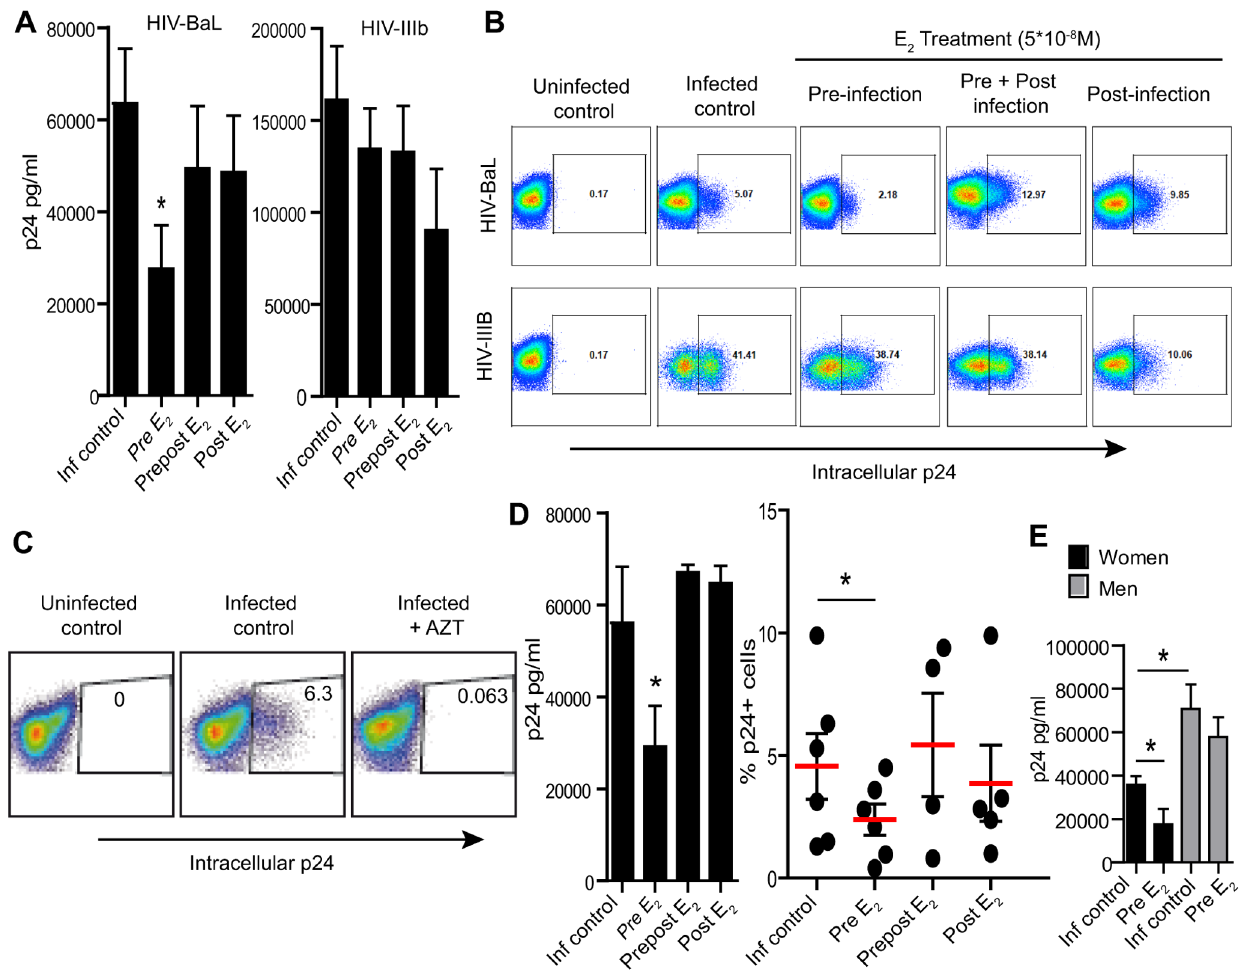
Figure 1. Effect of E 2 on HIV-infection of CD4 + T-cells. A) Released p24 levels in the culture media after 7 days of infection when cells where pre-treated with E 2 for 3 days (pre E 2 ), treated with E 2 before and after infection (prepost E 2 ) or only after infection (post E 2 ). Bars represent mean 6 SEM from 7 independent experiments with different donors. *P , 0.05. B) Intracellular p24 levels after 7 days of infection, representative of n=7. C) Intracellular p24 levels after 7 days of infection in the presence of Zidovudine (AZT). D) Released p24 levels in the culture media (left panel) and intracellular p24 (right panel) after 7 days of infection when cells where pre-treated with E 2 for 1 day (pre E 2 ), treated with E 2 before and after infection (prepost E 2 ) or only after infection (post E 2 ). Bars represent mean 6 SEM from 6 independent experiments with different donors. *P , 0.05. E) Released p24 in the culture media after 7 days of infection in CD4 + T-cells from women (black bars; N=6) or men (grey bars; N=5). *P ,